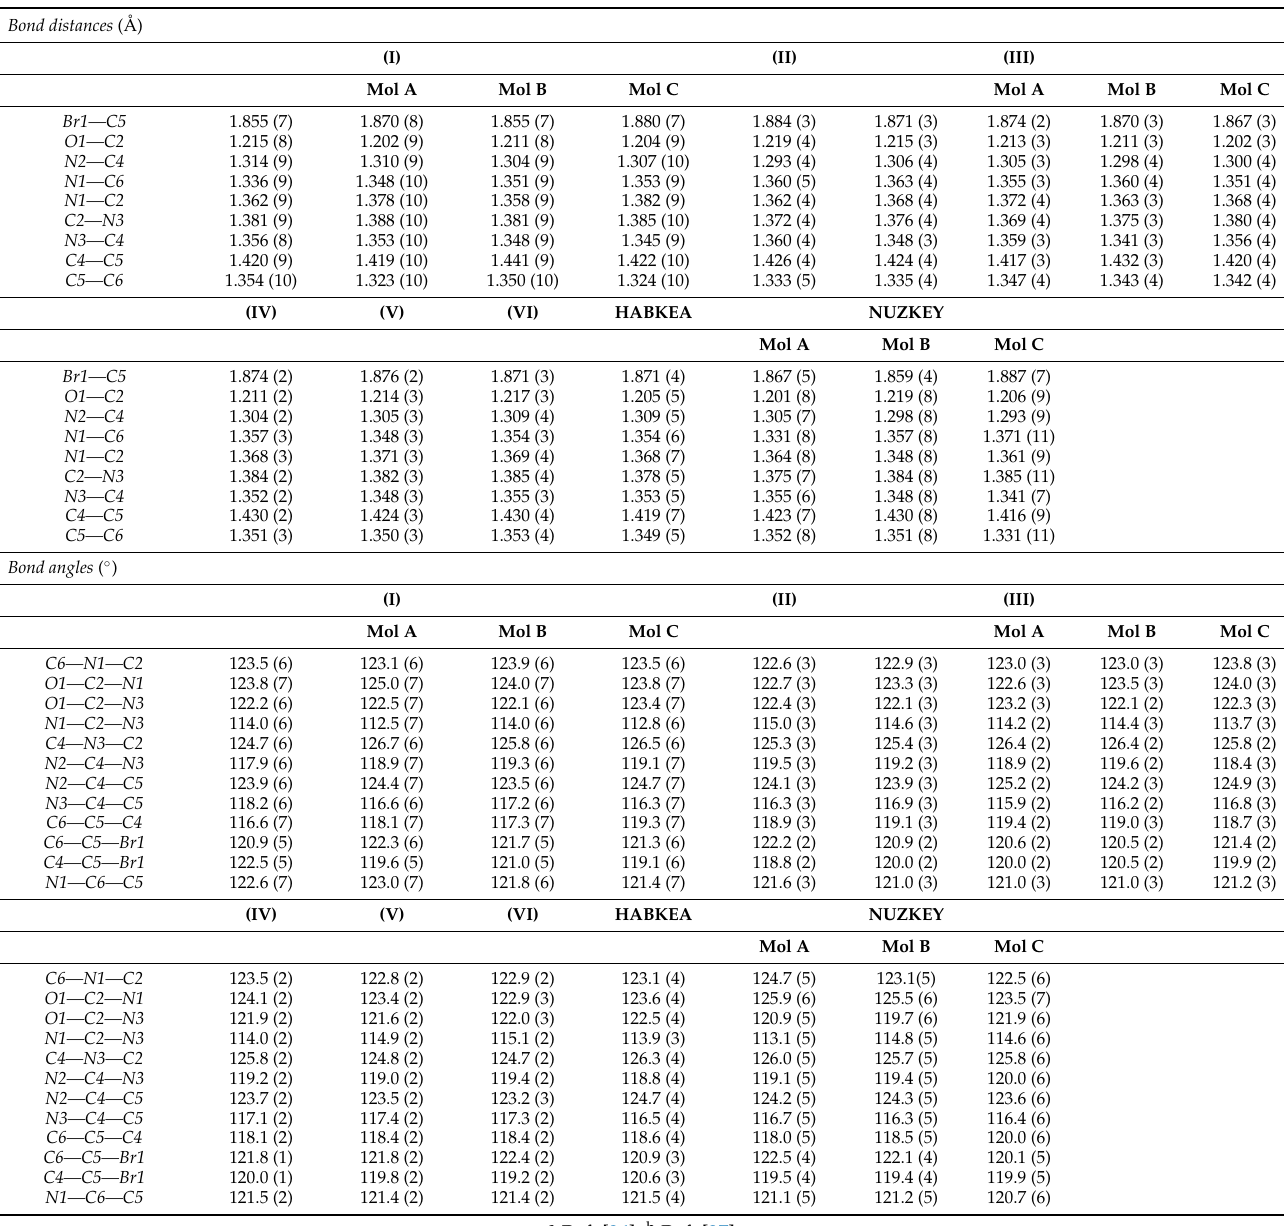
Table 7. Selected geometric parameters of 5-bromocytosinium cation for compounds ( I – VI ), HABKEA a and NUZKEY b . Bond distances